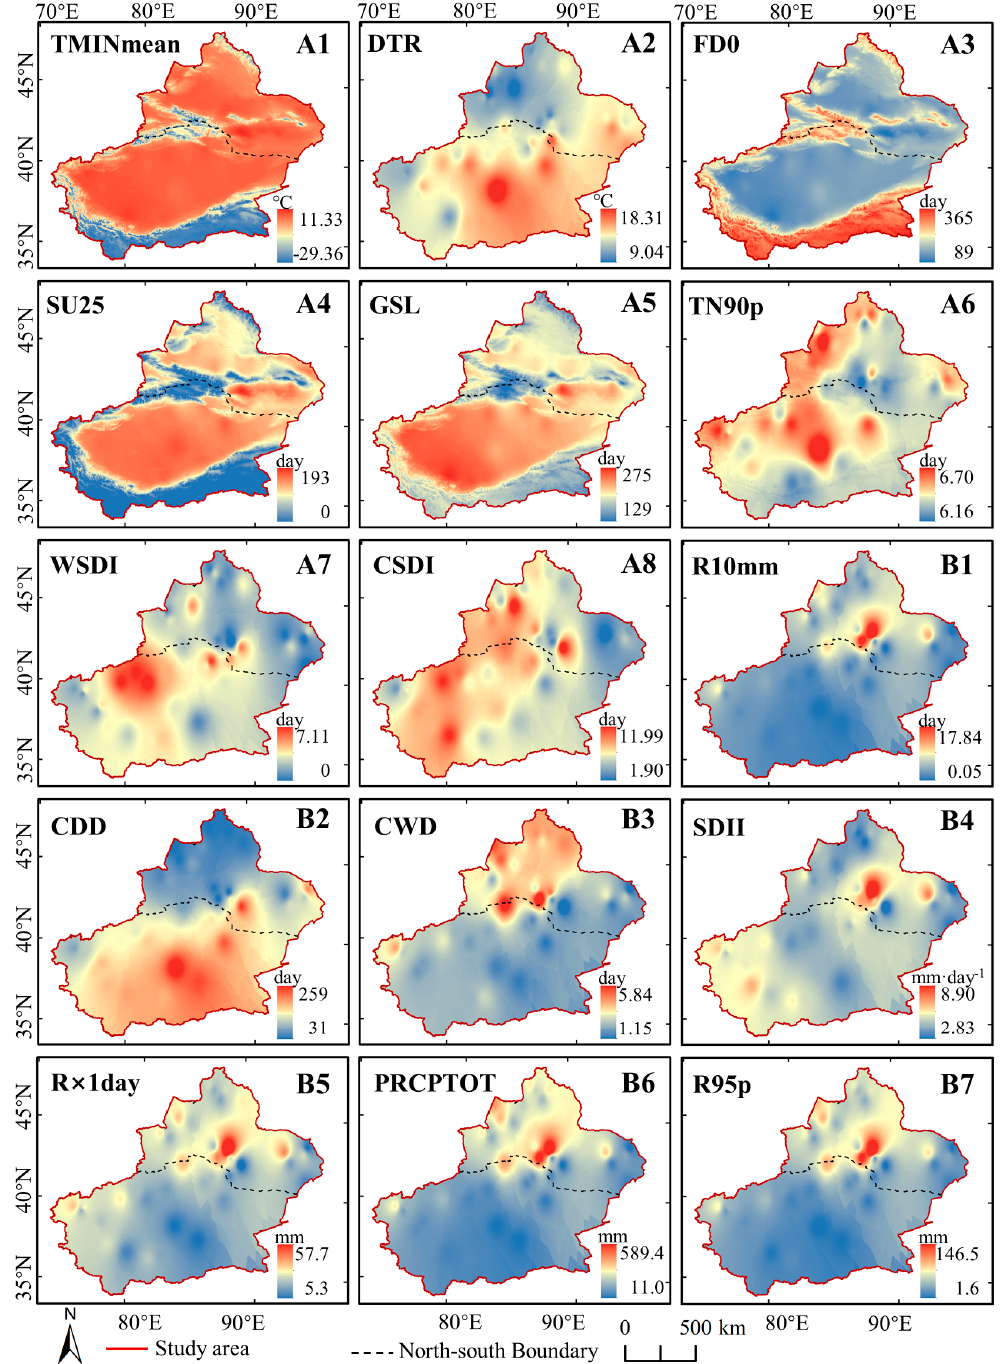
Figure 5. Yearly average extreme climate indices in Xinjiang during 2000–2018. The meanings of the abbreviation are as follows: Mean Minimum Temperature (TMINmean); Diurnal temperature range (DTR); Frost day (FD0); Summer days (SU25); Growing season length (GSL); Warm nights (TN90p); Warm speel duration index (WSDI); Cold speel duration index (CSDI); Number of heavy precipitation days (R10mm); Consecutive dry days (CDD); Consecutive wet days (CWD); Simple daily intensity index (SDII); Maximum 1-day precipitation (R × 1day); Wet day precipitation (PRCPTOT); Very wet day precipitation (R95p).